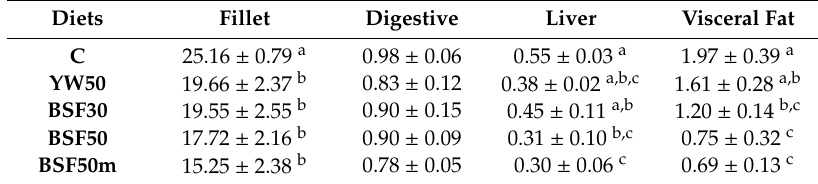
Table 3. Internal organs’ weight (g) of Dicentrarchus labrax fed di ff erent experimental diets ( n = 6) Diets